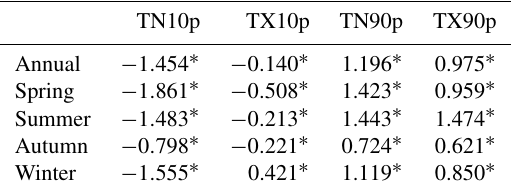
Table 7. Trends in annual and seasonal temperature extremes of cold nights (TN10p), cold days (TX10p), warm nights (TN90p) and warm days (TX90p) for daily newly constructed temperatures in Tianjin (unit – d per decade). TN10p TX10p